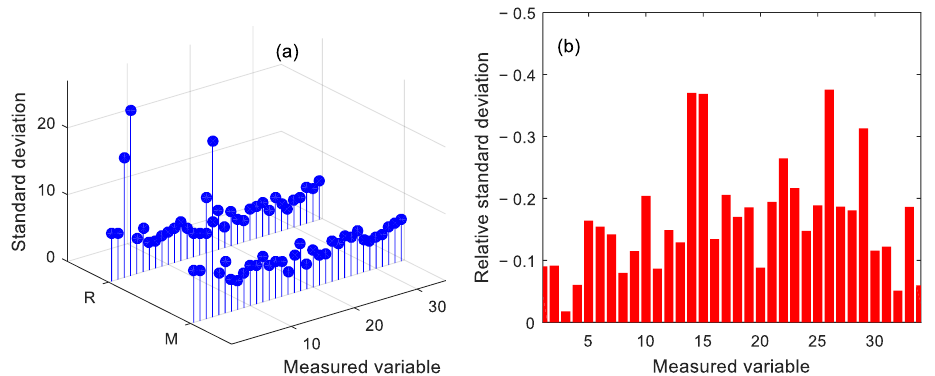
Figure 4. The comparison of data reconciliation: ( a ) the standard deviation of the reconciled data and the measured data; ( b ) the relative standard deviation of measured variables.